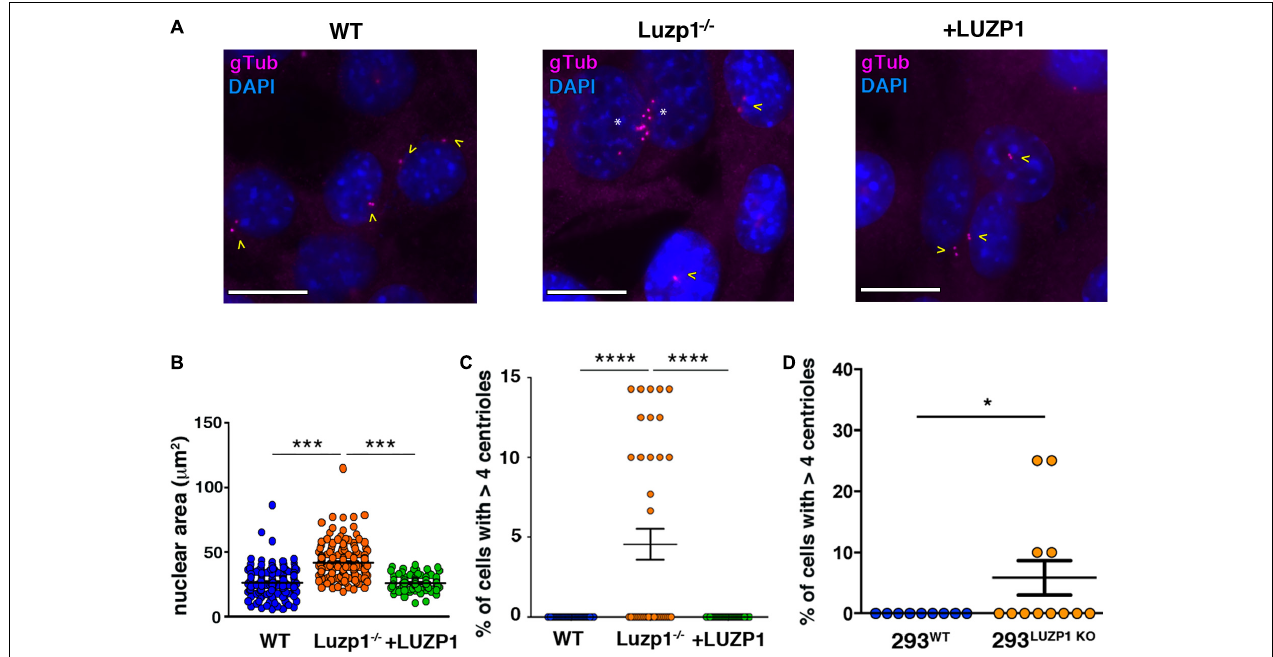
FIGURE 4 | Luzp1 − / − cells exhibit bigger nuclei and multiple centrioles. (A) Micrographs showing centrioles in wild-type Shh-LIGHT2 cells (WT), Shh-LIGHT2 cells lacking Luzp1 (Luzp1 − / − ) and Luzp1 − / − cells rescued with Luzp1-YFP (+ LUZP1) analyzed during cycling conditions. Centrioles were visualized using gamma-tubulin antibody (gTub, magenta) and nuclei were counterstained using DAPI (blue). Scale bar, 5 µ m. Cells containing 2 centrioles are marked with yellow arrowheads and those containing multiple centrioles with white asterisks. (B) Graphical representation of nuclear area of Shh-LIGHT2 WT ( n = 178 micrographs; blue dots), Luzp1 − / − ( n = 185 micrographs; orange dots) and + LUZP1 cells ( n = 90 micrographs; green dots). P -values were calculated using Kruskall-Wallis and Dunn’s multiple comparisons tests. (C) Graphical representation of the percentage of cells that exhibit more than 4 centrioles in (A) . WT, n = 37 micrographs, blue dots; Luzp1 − / − , n = 38 micrographs, orange dots; + LUZP1, n = 35 micrographs, green dots. P -values were calculated using Kruskall-Wallis and Dunn’s multiple comparisons tests. (D) Graphical representation of the percentage of cells that exhibit more than 4 centrioles in wild-type HEK 293FT (293 WT ) and HEK 293FT cells lacking Luzp1 (293 LUZP1KO ). 293 WT , n = 9 micrographs, blue dots; 293 LUZP1KO , n = 12 micrographs, orange dots. P -values were calculated using Mann Whitney- U test. The graphs in (B–D) represent the Mean and SEM. ∗ P < 0.05; ∗∗∗ P < 0.001; ∗∗∗∗ P <